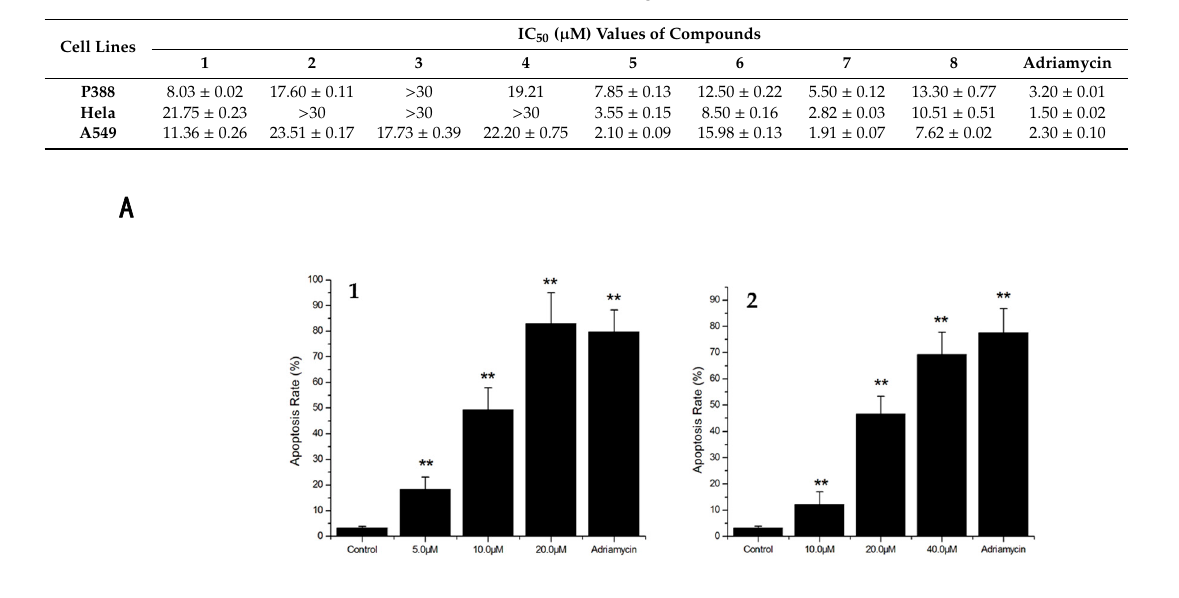
Table 2. IC 50 values of withanolides 1 – 8 against human tumor cell lines.